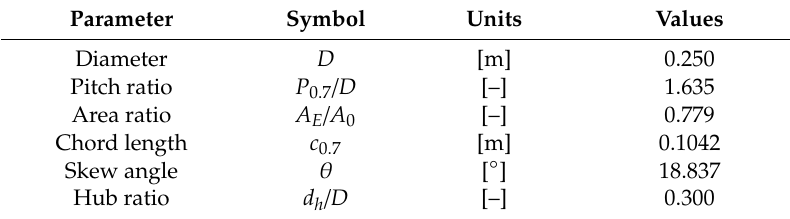
Table 1. Main particulars of the Potsdam propeller test case (PPTC) propeller.